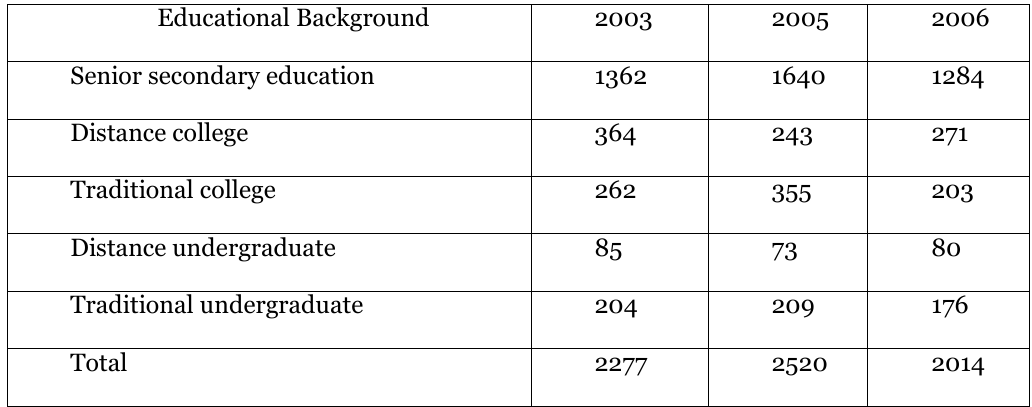
Educational Backgrounds of Sample